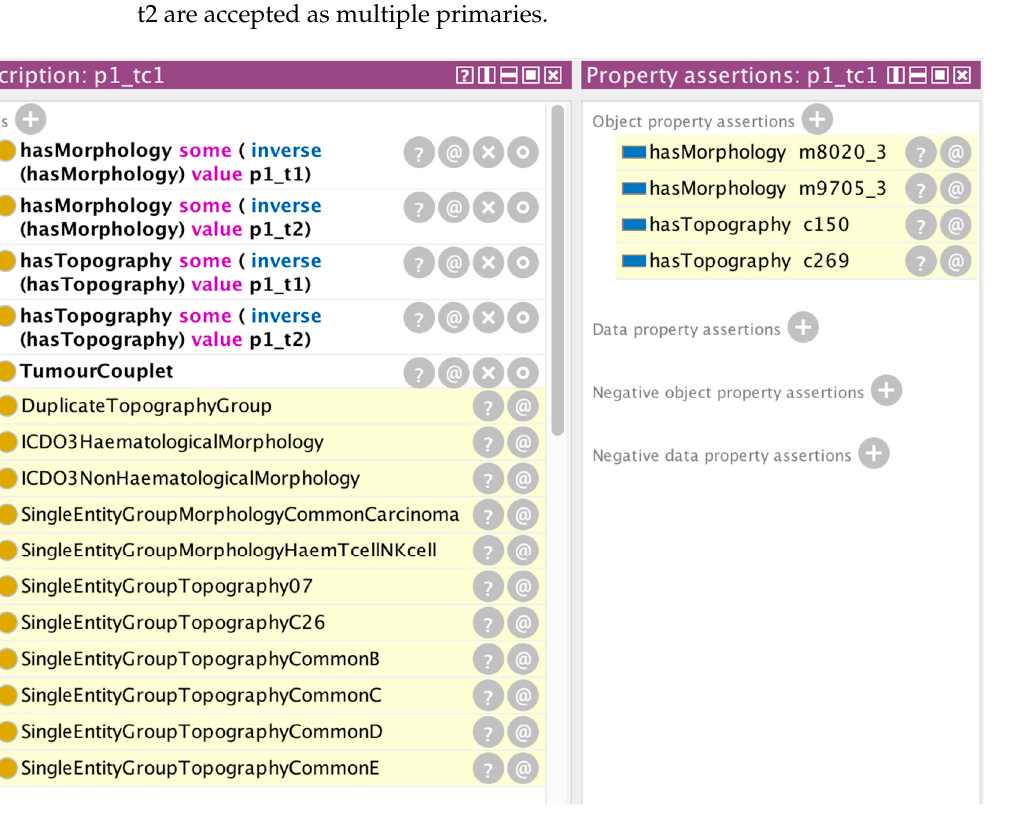
Figure 4. Results of the reasoning operation for the tumour couplet p1_tc2. Although the topography codes are equivalent via Axiom (4), the morphology codes are independent and the couplet is a valid MPT.